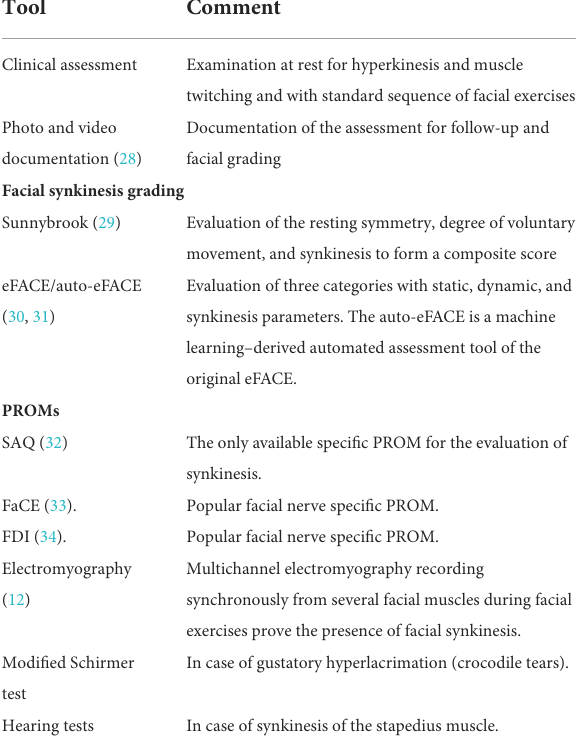
TABLE 2 Recommended assessment tools and outcome